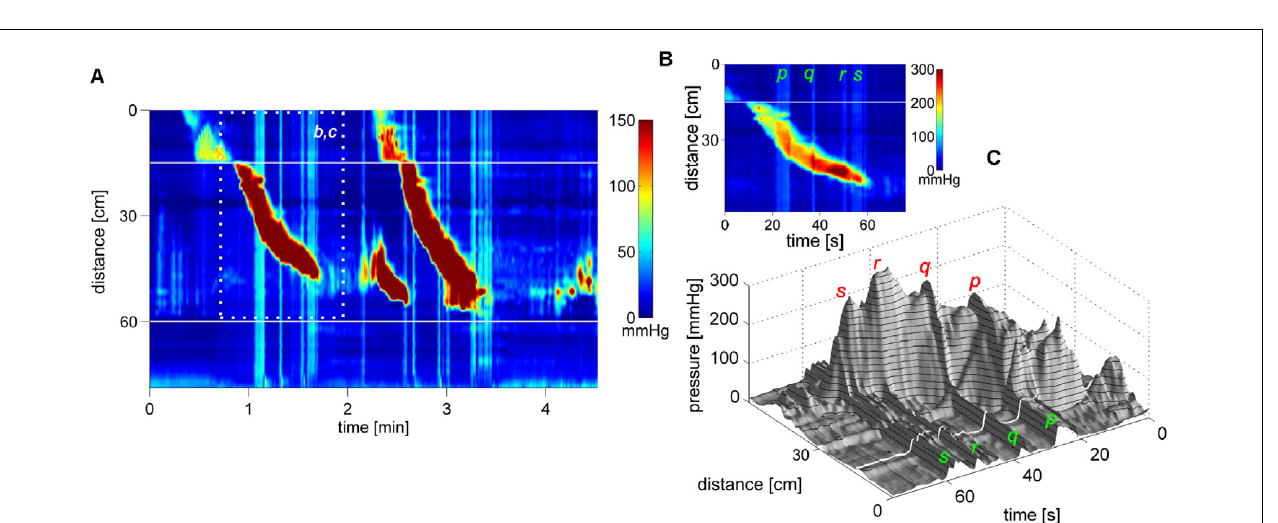
FIGURE 12 | High amplitude SPWs in response to rectal bisacodyl. A 10 mg bisacodyl suspension was injected in the rectum at 16 min. Between 3 and 4 min, data acquisition was halted due to refilling of water reservoirs. This subject produced normal HAPWs in response to balloon distention (not shown). The average amplitude of the SPWs in response to bisacodyl was 32.2 mmHg. All 4 SPWs were associated with liquid outflow and the middle two SPWs with gas expulsion as well.